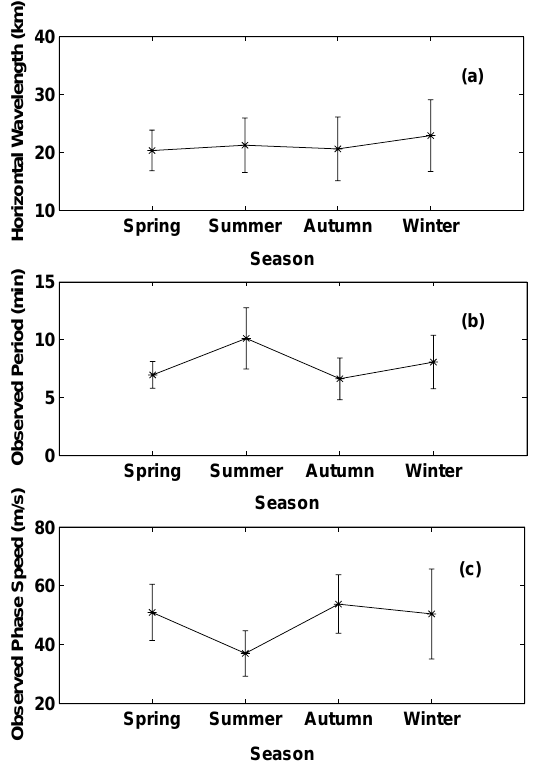
Fig. 5. The seasonal variations in the averaged band events param- eters. (a) Averaged horizontal wavelength, (b) averaged observed period, (c) averaged horizontal phase speed. Error bars give mean errors for each season.